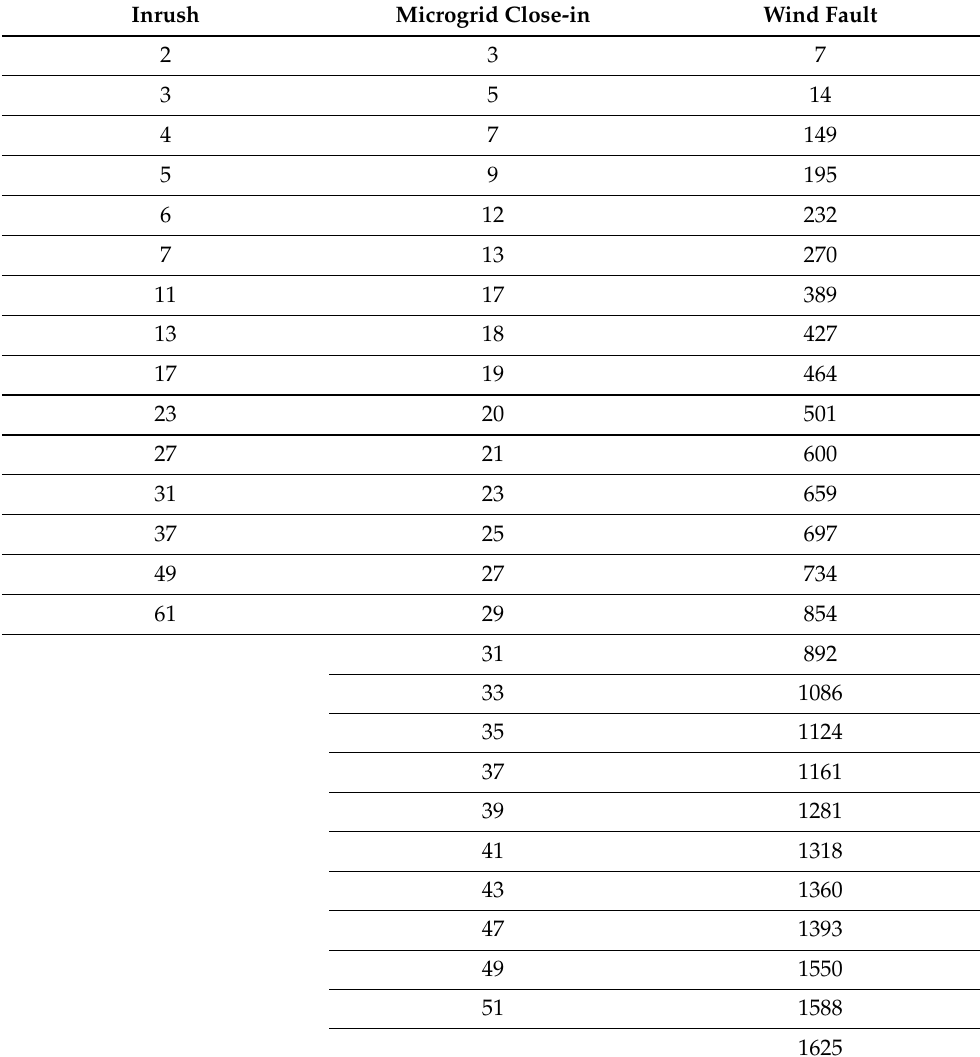
Table 1. Selected harmonics for each event of interest. Inrush Microgrid Close-in Wind